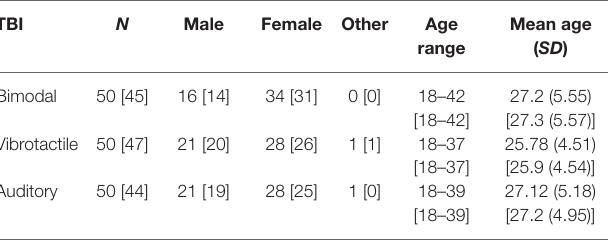
TABLE 1 | Sample description in terms of biographical